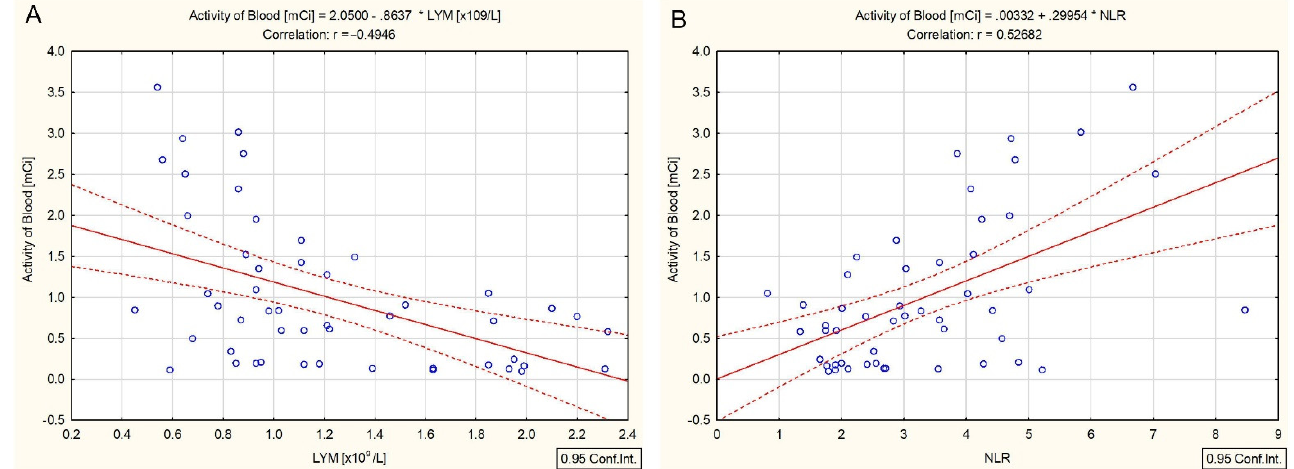
Figure 6. Correlation measured at 69 h post-administration between the whole blood activity and absolute lymphocytes count ( A ) and NLR ( B ).